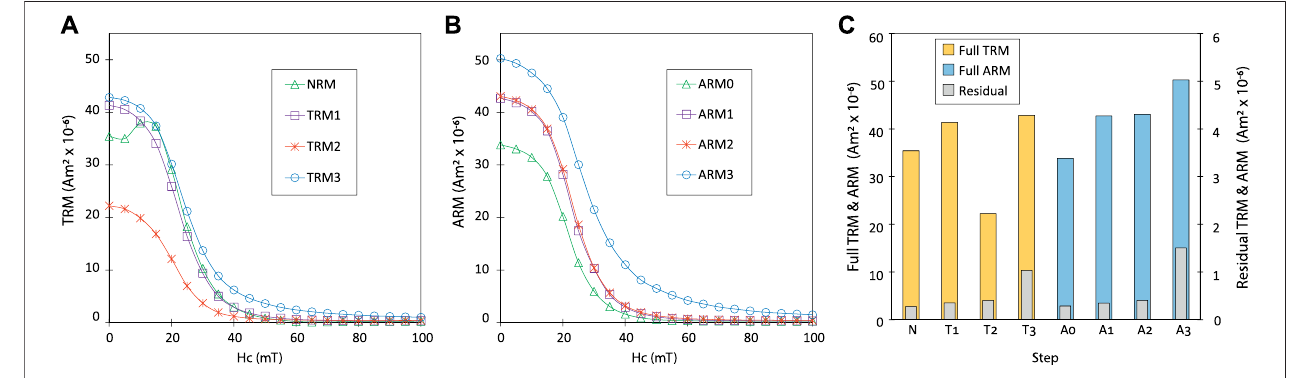
FIGURE 6 | AF demagnetisation information for specimen 6.2A of site MD6. (A) Vector-subtracted TRM AF demagnetisation spectra. (B) Vector-subtracted ARM AF demagnetisation spectra. (C) Magnitudes of the remanence and residual magnetisations.